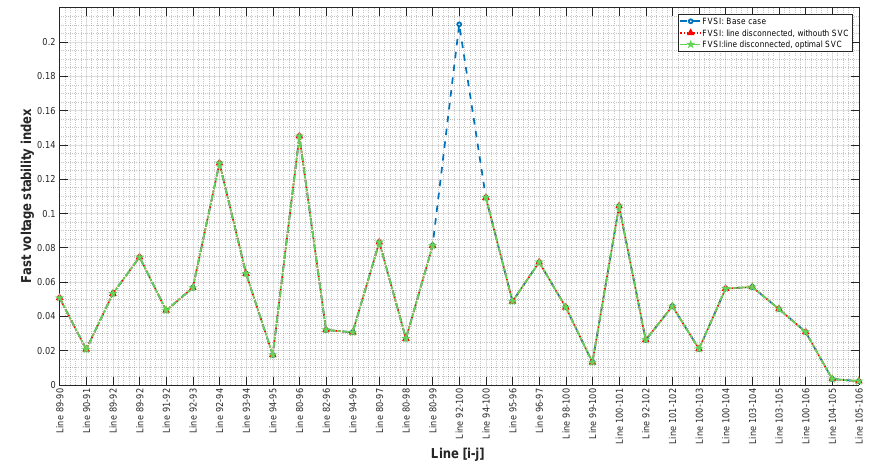
Figure 17. Third study case: FVSIs before/after contingencies and with SVC